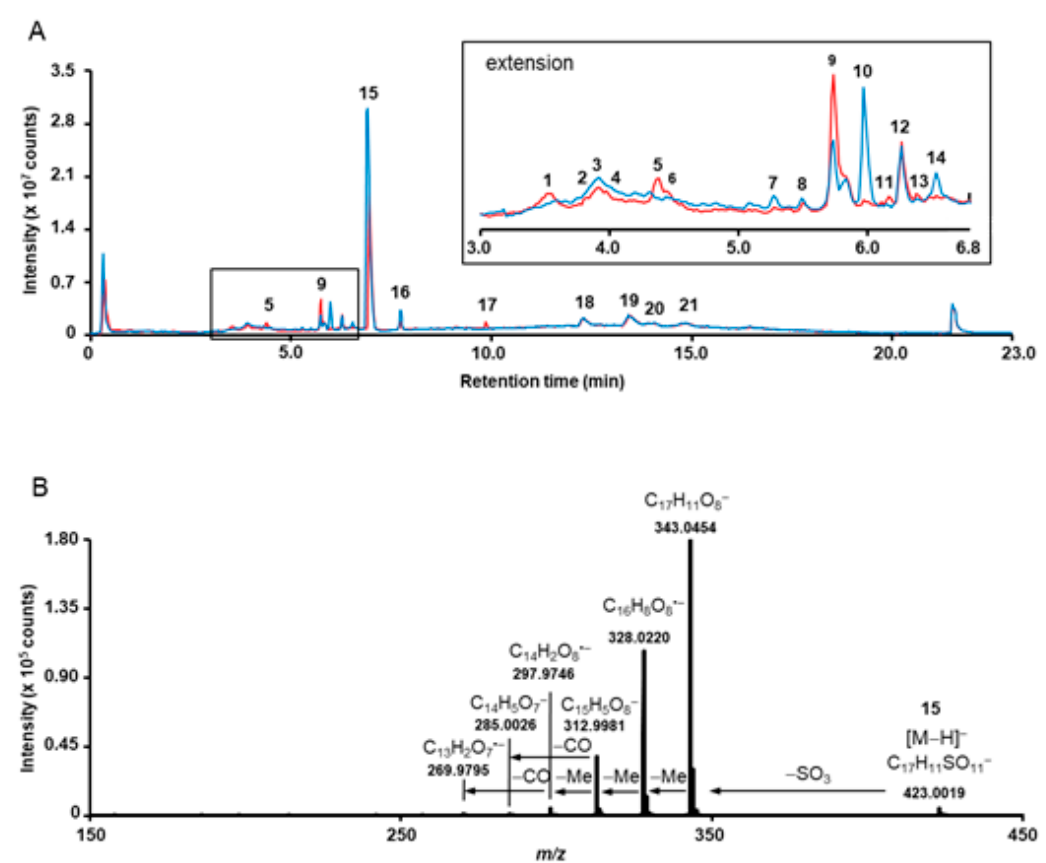
Figure 2. Overlay of the total ion chromatograms (TICs), acquired for the methanolic extracts obtained from Lumnitzera littorea (red, LL11) and L. racemosa (blue, LR15) roots ( A ) and tandem mass spectrum, acquired for the m/z 423.0 correspond- ing to 3,3’,4’-tri- O -methylellagic acid 4-sulfate ( 15) ( B ). The insert in A represent the chromatogram section in the t R range 3.0–6.8 min. The individual annotated metabolites are numbered with rising retention time according to Table